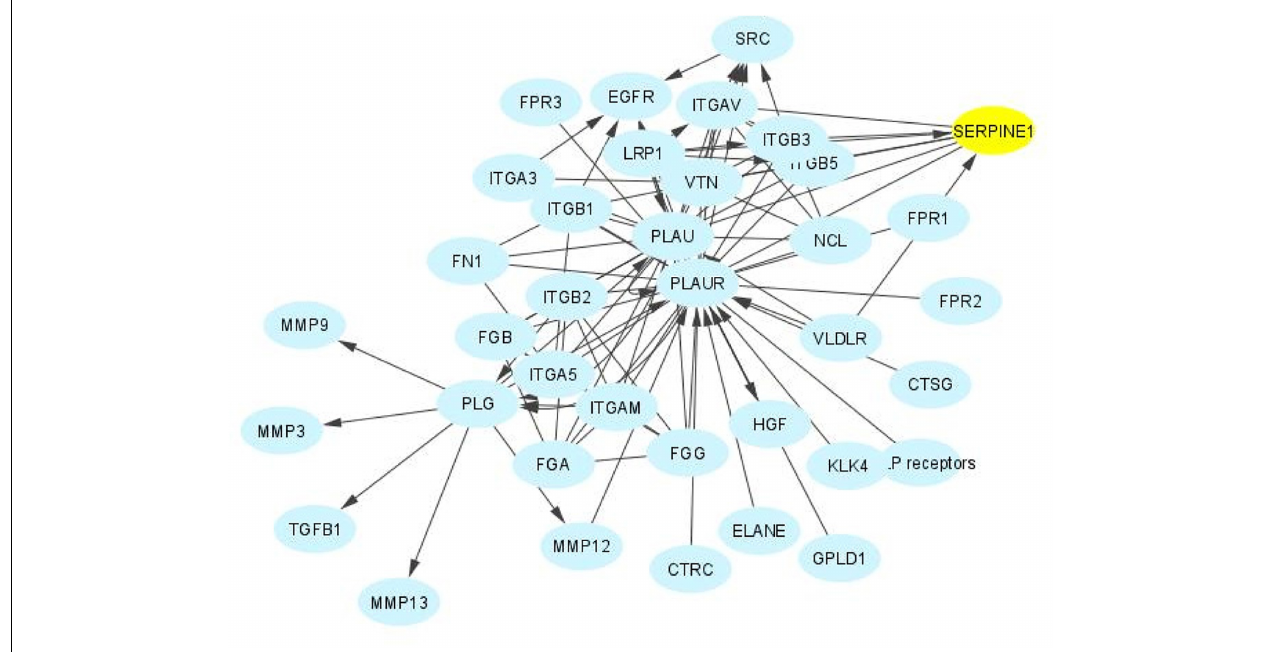
FIGURE 4 | The SERPINE1 interactome. SERPINE1 (PAI-1) is a major hub factor in the regulation of the immediate pericellular proteolytic cascade. PAI-1 titrates the conversion of plasminogen to plasmin by binding to and inhibiting the catalytic activity of urokinase plasminogen activator (PLAU), effectively attenuating stromal proteolysis while promoting matrix accumulation and the onset and progression of fibrotic disease regardless of etiology. PAI-1 also regulates cellular attachment and migration, key aspects of the injury repair program, largely by altering interaction of the PLAU-PLAU receptor (PLAUR) complex with its associated integrins and by functioning as a ligand for LRP1 to initiate post-receptor downstream